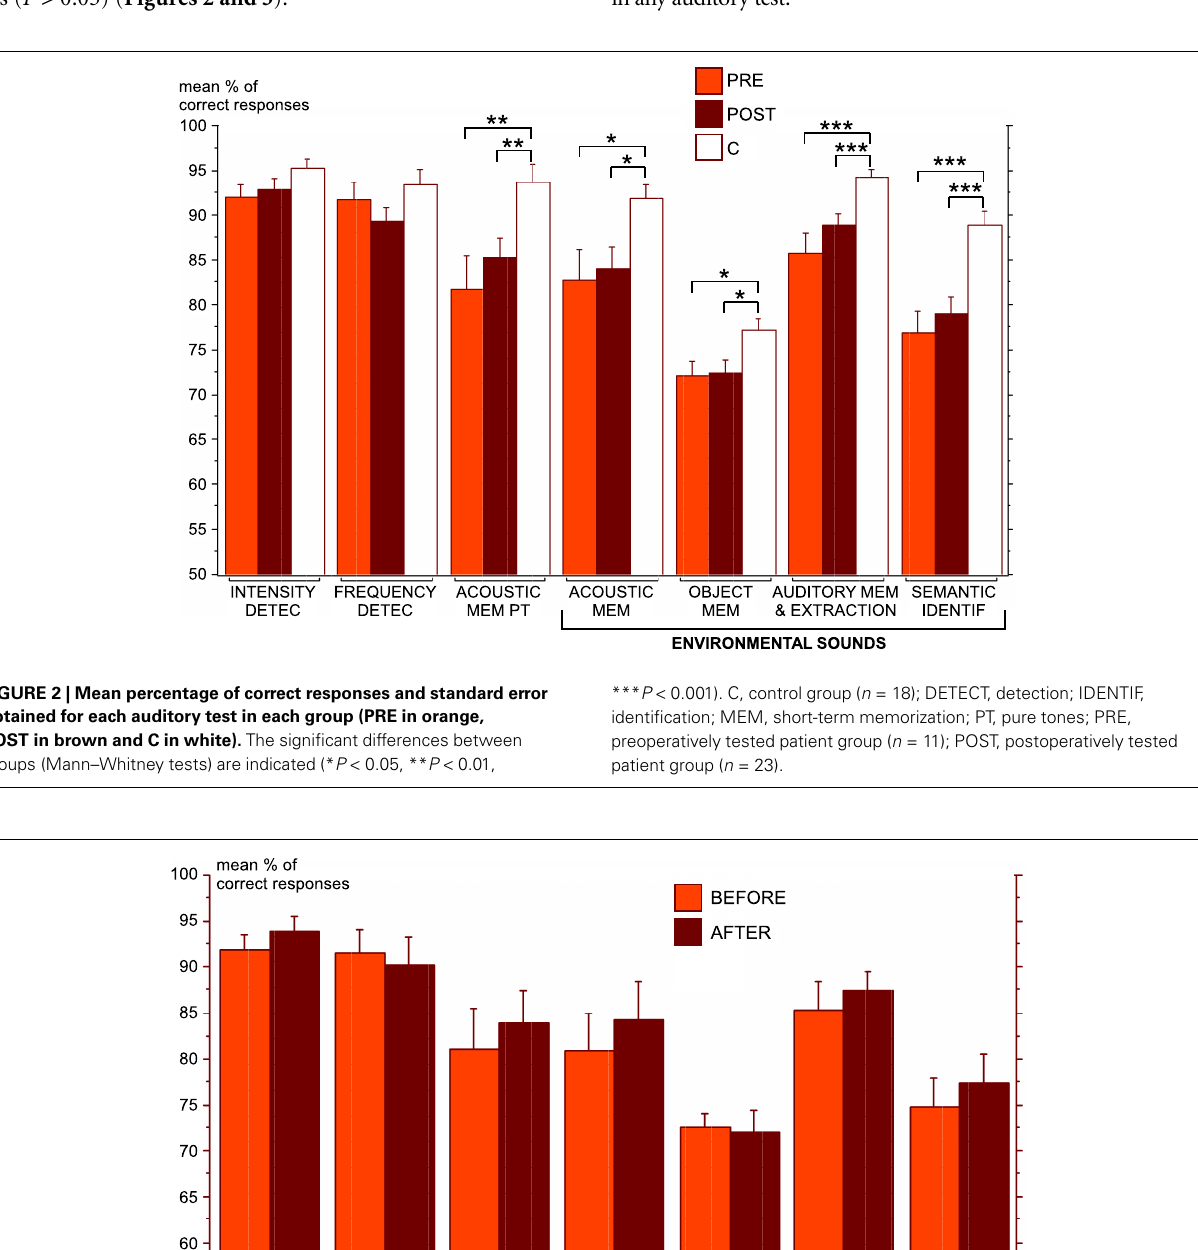
has been found between mean percentage of correct responses before and after surgery. DETECT, detection; IDENTIF, identifi cation; MEM, short-term memorization; PT, pure